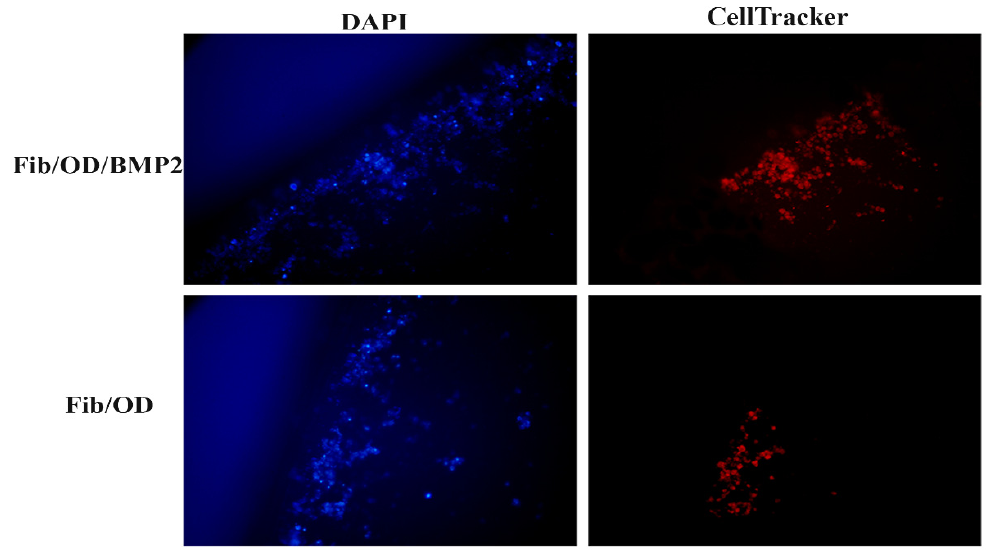
Figure 6. Cell tracking. C-EnSCs were labeled with DiI dye to follow homing of the transplanted cells in the injured site 8 weeks after transplantation. The slides were investigated under a fluorescent microscope, and the labeled cells were observable in red at the injured locus (10×) .